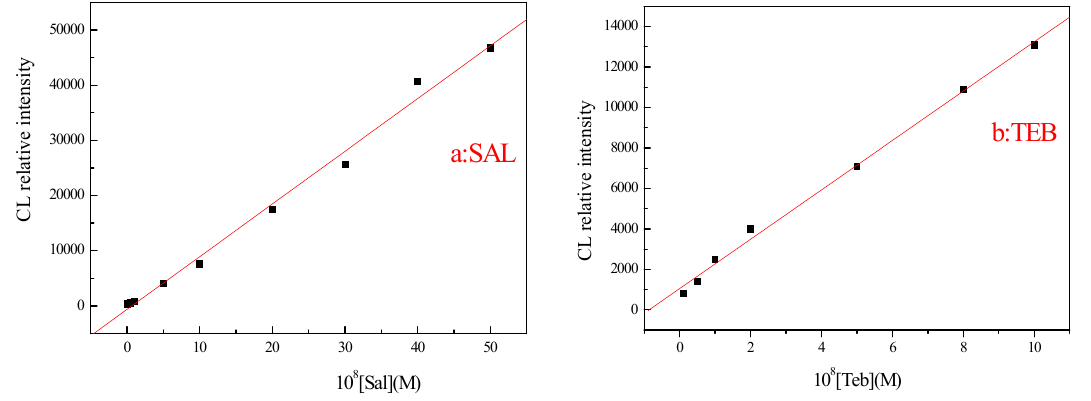
Figure 4. Plots of the CL intensities versus [SAL] and [TEB]. Conditions: ( a ) [Ni(IV)] = 6.0 × 10 −7 M (in 0.003 M OH − ); [Lu] = 2.0 × 10 −7 M (in 0.002 M OH − ); [SAL] = 1.0 × 10 −7 M; ( b ) [Ni(IV)] = 6.0 × 10 −7 M (in 0.001 M OH − ); [Lu] = 2.0 × 10 −6 M (in 0.001 M OH − ); [TEB] = 1.0 × 10 −7 M. Table 2. Recoveries obtained for SAL and TEB in Urine and Feed samples.